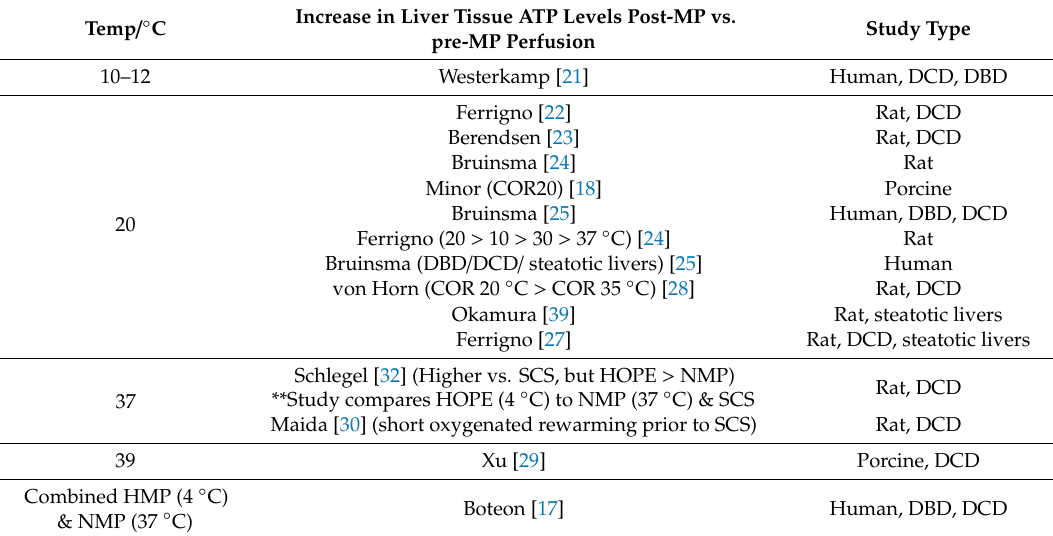
Table 11. MP studies that reported liver tissue ATP